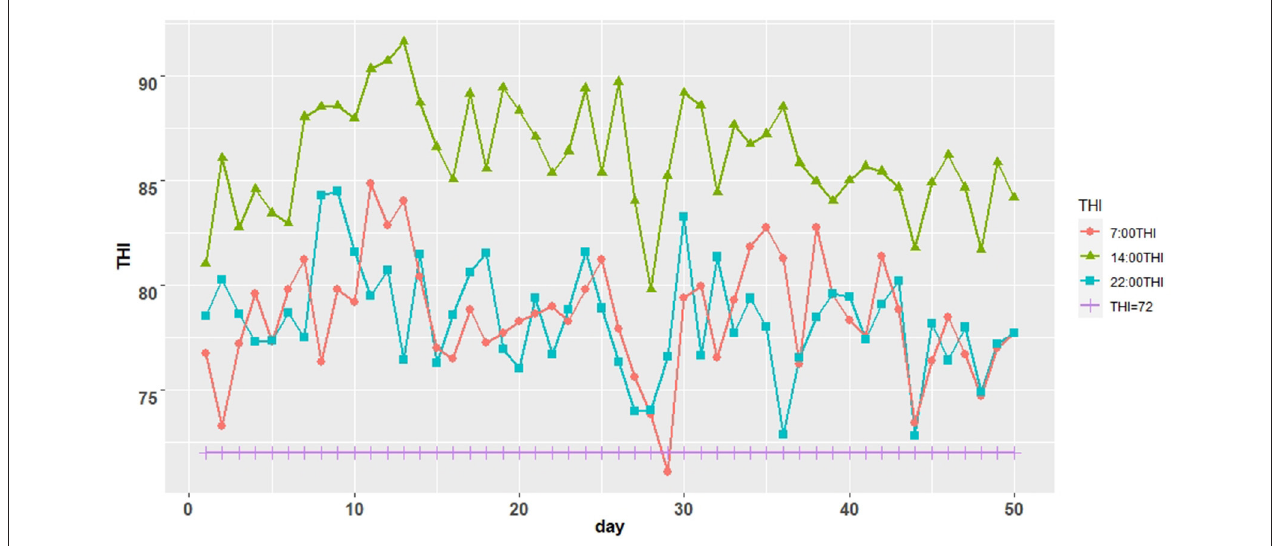
FIGURE 1 | Trend graph of temperature and humidity index (THI) of Dairy barn.